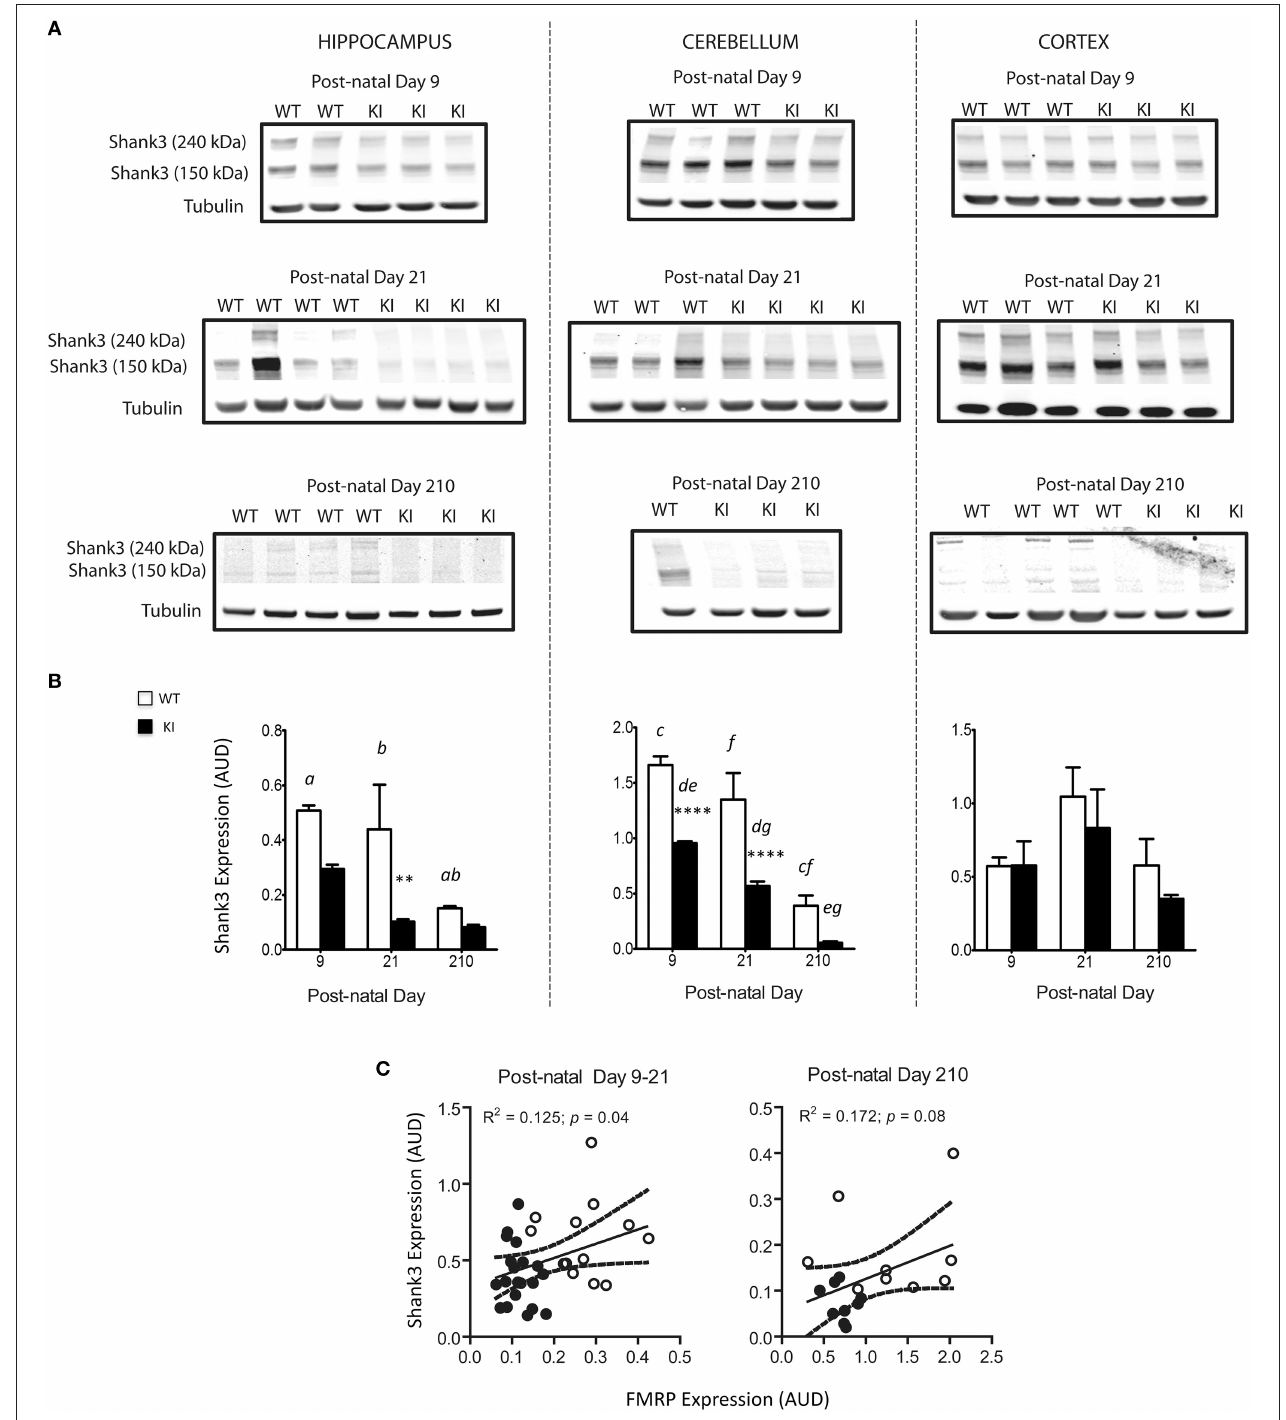
FIGURE 8 | Brain Shank3 protein levels in WT and KI mice. (A) Western blots for Shank3 protein expression levels in hippocampus, cerebellum, and cortex were performed at PND 9, 21, and 210 from WT (white) and KI (black) mice as described in details in the Materials and Methods Section. Further, images taken with acetone-precipitated samples and normalized by either tubulin or GADPH are found under Supplementary Figure 1. (B) Densitometry data is shown as mean ± SEM, n = 4–5 individuals per genotype, per time point, ran individually. Statistical analysis was performed by two-way ANOVA, followed by Tukey’s HSD post-hoc test for multiple comparisons. Statistically significant differences between WT and KI are indicated by asterisks as follows: Hippocampus: ** p = 0.0054; Cerebellum: **** p < 0.0001. Statistically significant differences among time points are indicated by letters as follows: p = 0.0074 ( a ), p = 0.0267 ( b ), p < 0.0001 ( c, e, f ), p = 0.0217( d